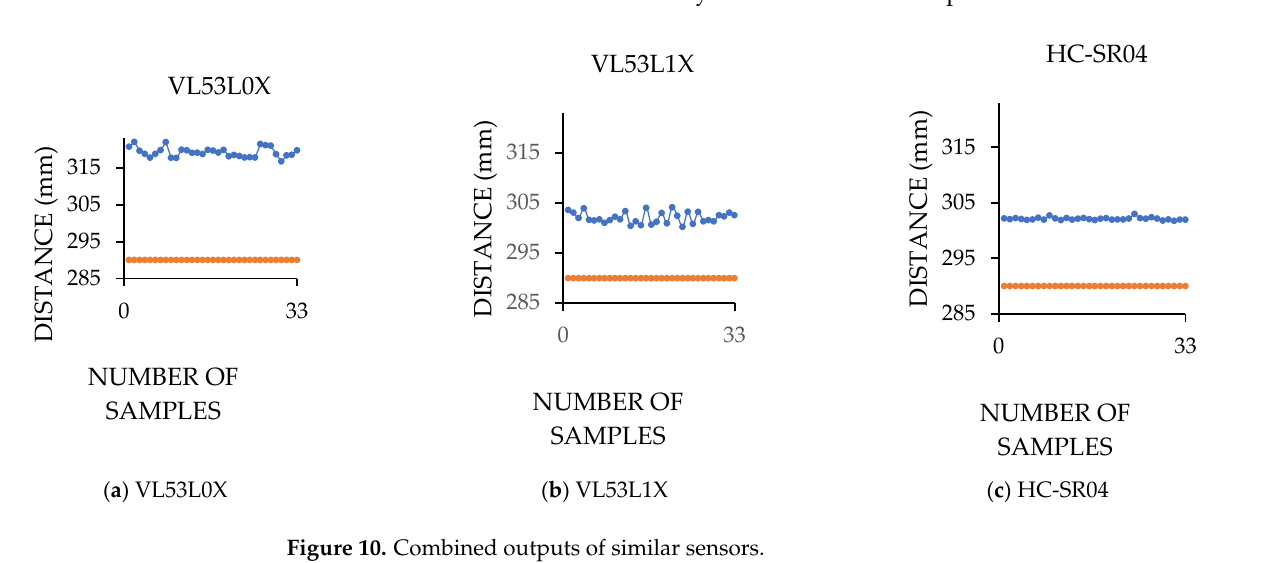
Figure 9. Filtered output of distance sensors for an experiment: ( a ) results of VL53L0X, ( b ) results of VL53L1X, and ( c ) results of HC-SR04.